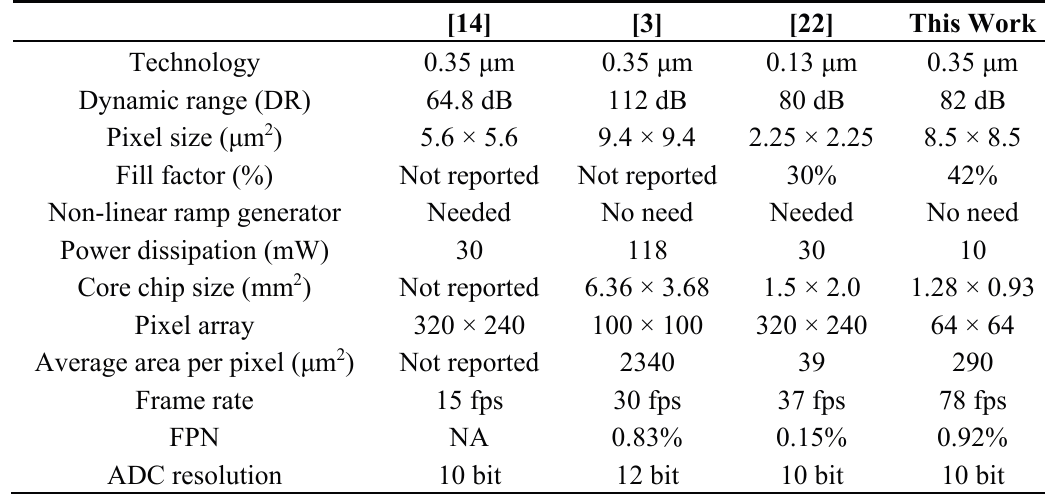
Table 2. Main chip characteristics and the detailed comparison with the previous analog gamma correction